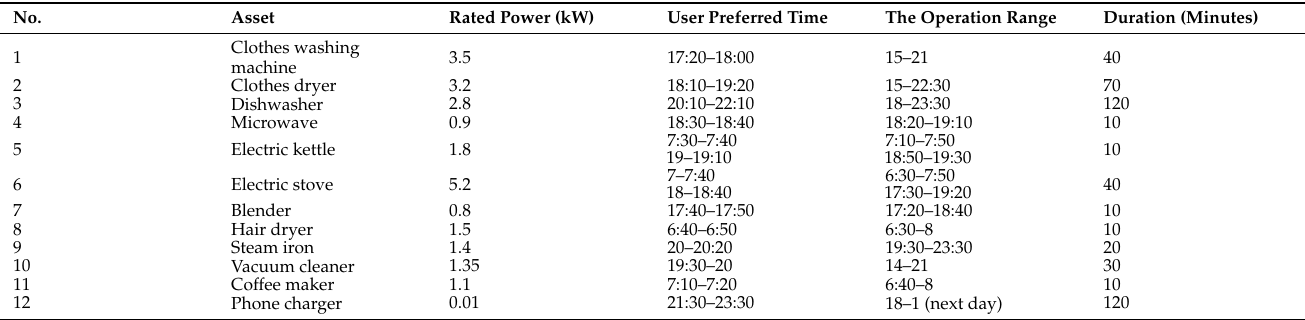
Table 1. Time-shiftable assets for a residential building.